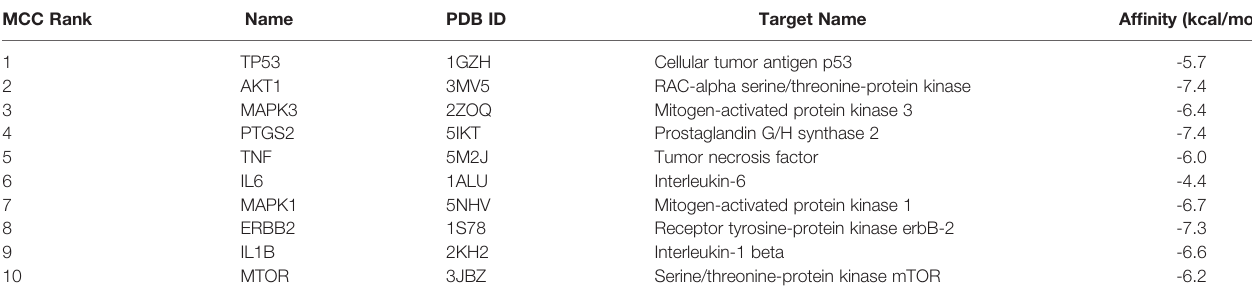
The top 10 hub proteins with its MCC ranking and their binding af fi nity with